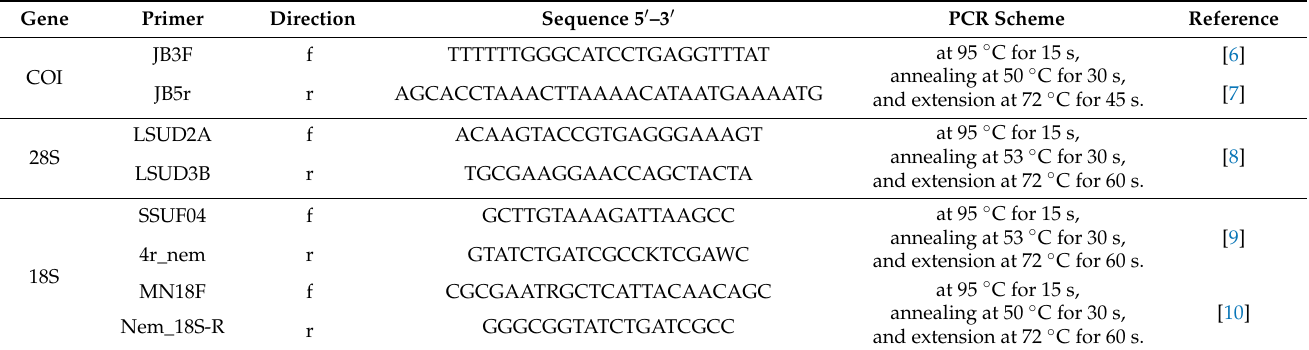
Table 1. Primers and annealing temperatures used in this study.